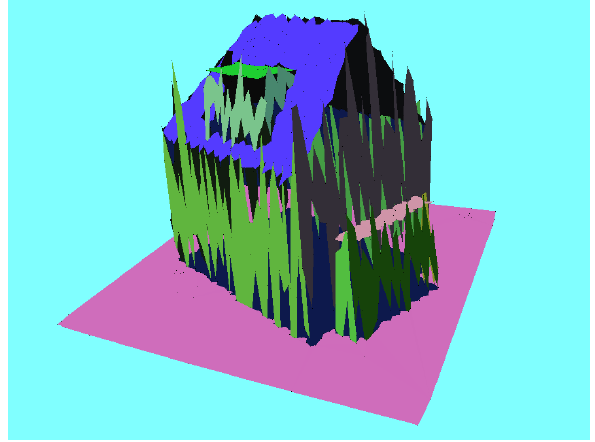
Figure 5. Result of TIN segmentation of the TIN of Figure 4.